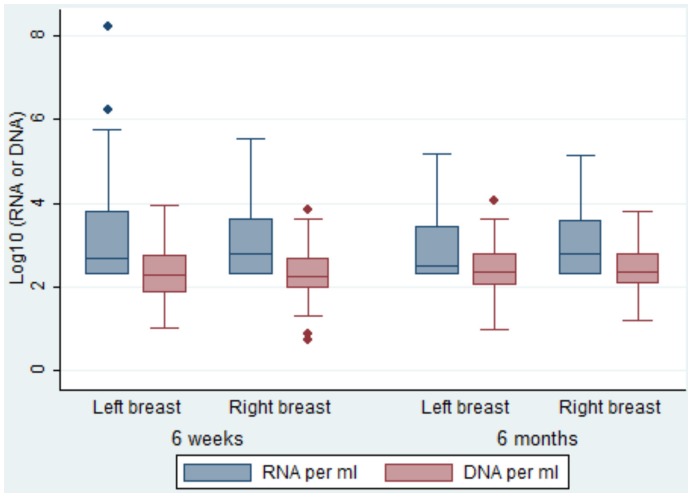
Distribution of log10 cell-free and cell-associated values (per ml) by breast and infant age.